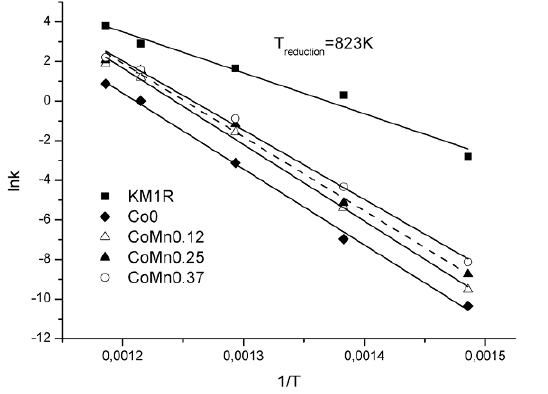
Figure 3. Dependence of the rate constant as a function of temperature.